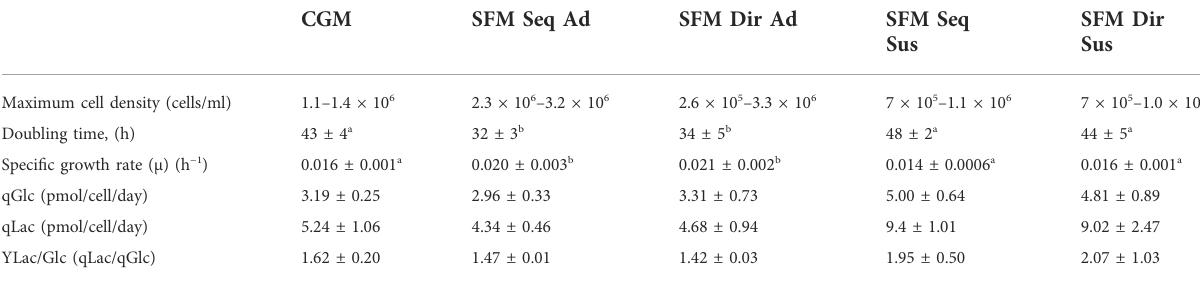
TABLE1Growthpro fi lesandBiochemicalanalysisofthe5differentculturesystems.Datanotsharingacommonsuperscriptalphabeticletterindicate signi fi cant difference ( p < 0.05) after Tukey posthoc test for multiple